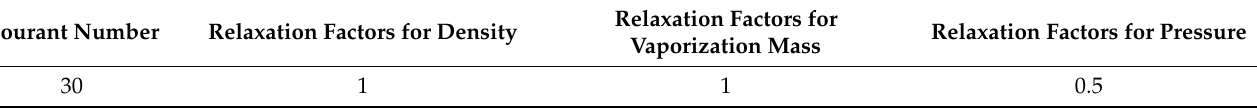
Table 3. Values of relaxation factors in CFD solution